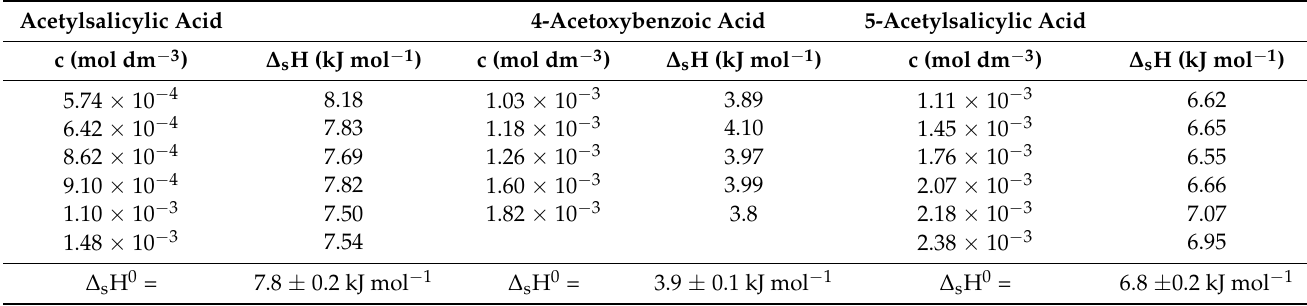
Table 5. Enthalpies of solution of acetylsalicylic acid, 4-acetoxybenzoic acid and 5-acetylsalicylic acid in DMF at 298.15